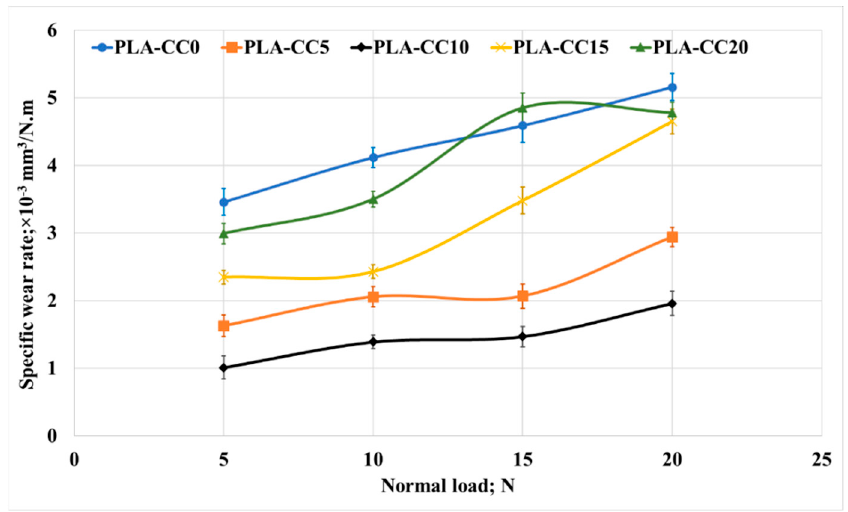
Figure 17. Specific wear rate of PLA-CC composites under different normal loads.